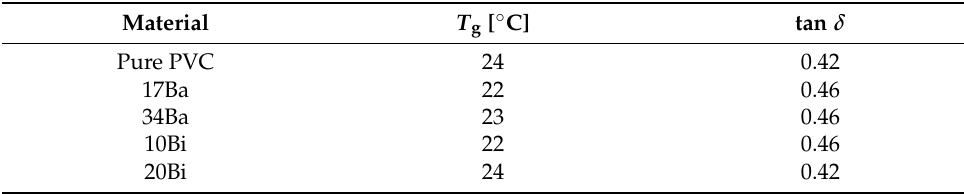
Table 3. Effect of radiopaque fillers on the phase transition